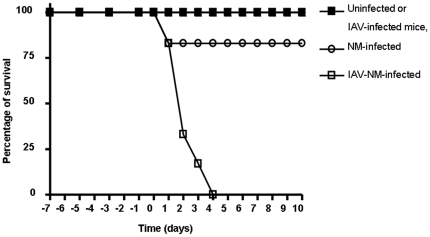
Survival curves of congenic transgenic mice expressing the human transferrin.Two groups of 7 mice were infected by influenza A virus (IAV) by intranasal inhalation. One group of 7 mice inhaled the same volume of phosphate saline buffer. At day 7 of the viral intranasal infection all the mice from the three groups were infected by intraperitoneal injection of 5*106 CFU of the strain 24198. The mice were observed during the whole period up to 10 days after the bacterial secondary challenge. The deaths were scored in each group and the data were expressed as a percentage of survival.